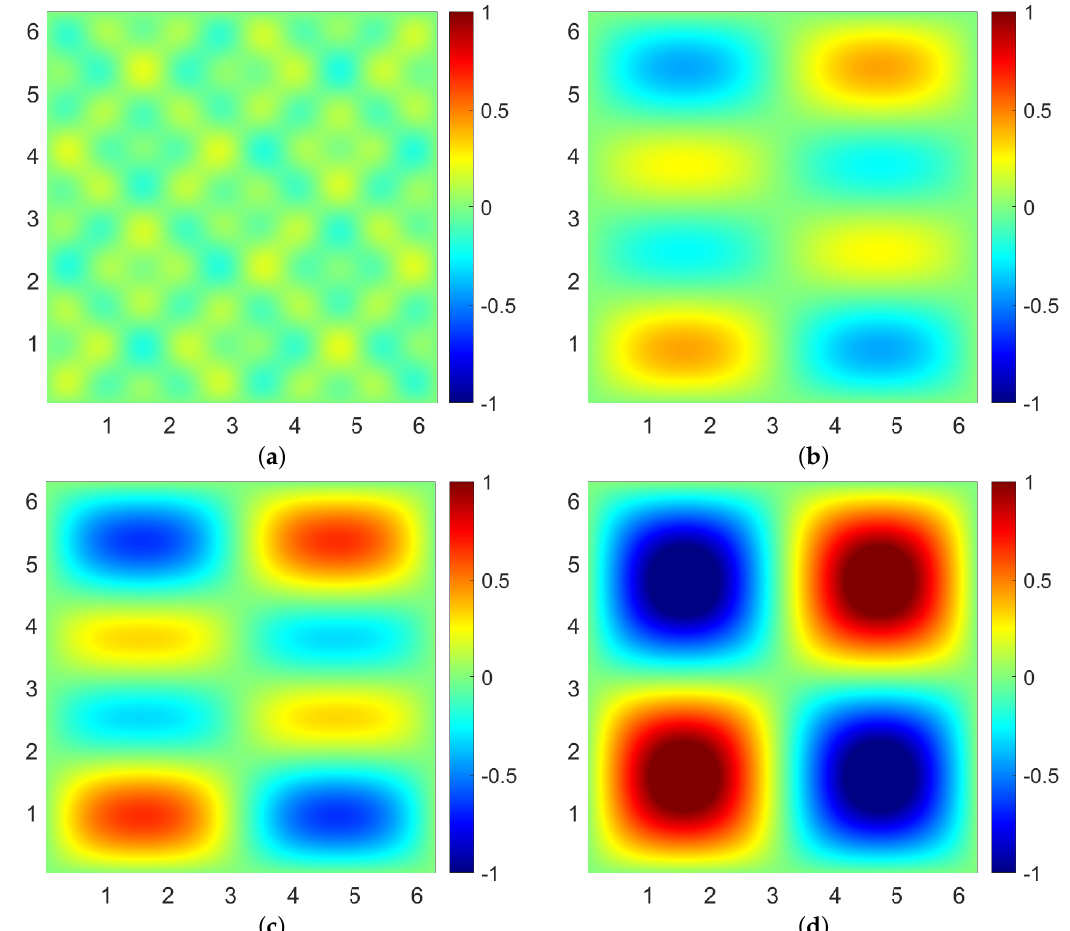
Figure 19. ( a – d ) are the snapshots of numerical solutions of the molecular beam epitaxy (MBE) growth model employing the initial condition (51) at t = 0, 5800 ∆ t , 7200 ∆ t , and 15,000 ∆ t , respectively. For colored figures, see the manuscript of web